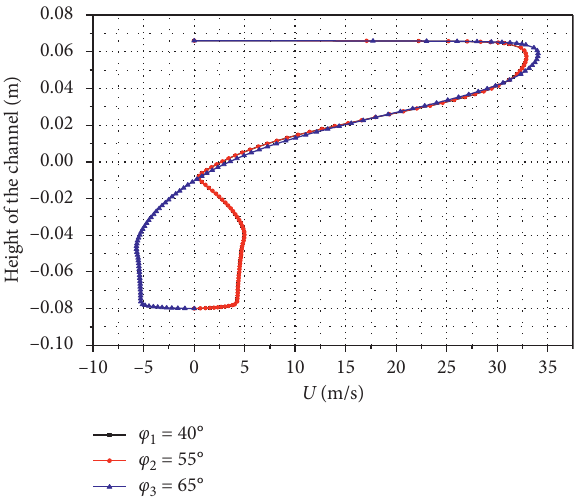
Figure 12: Distribution of the local Nusselt number along upper channel wall for φ 1 � 40 ° , φ 2 � 55 ° , and φ 3 � 65 °